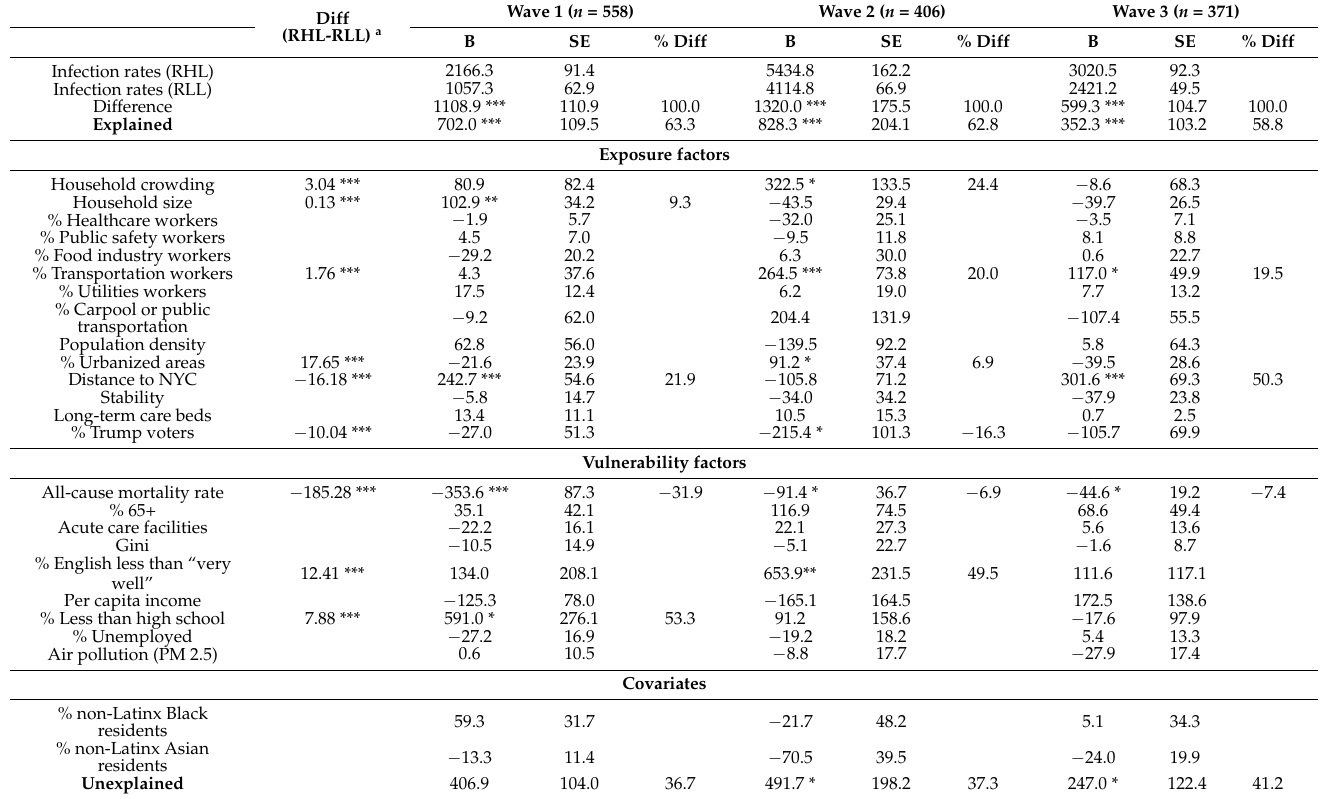
Table 2. Decomposition analysis contrasting RHL with RLL